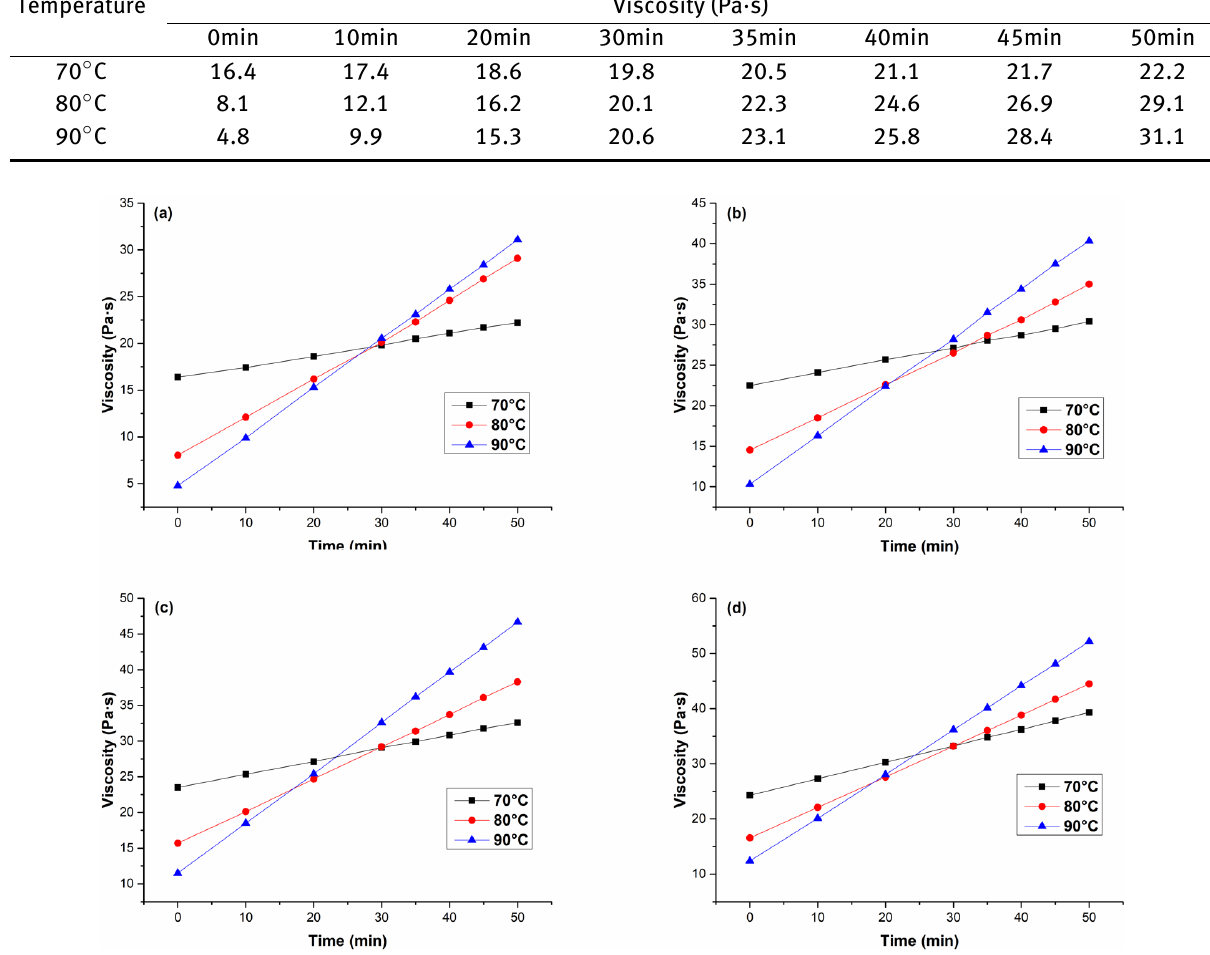
Figure 3: Viscosity-time curves for nano-silica content of (a) 0%, (b) 2%, (c) 4% and (d) 6%,